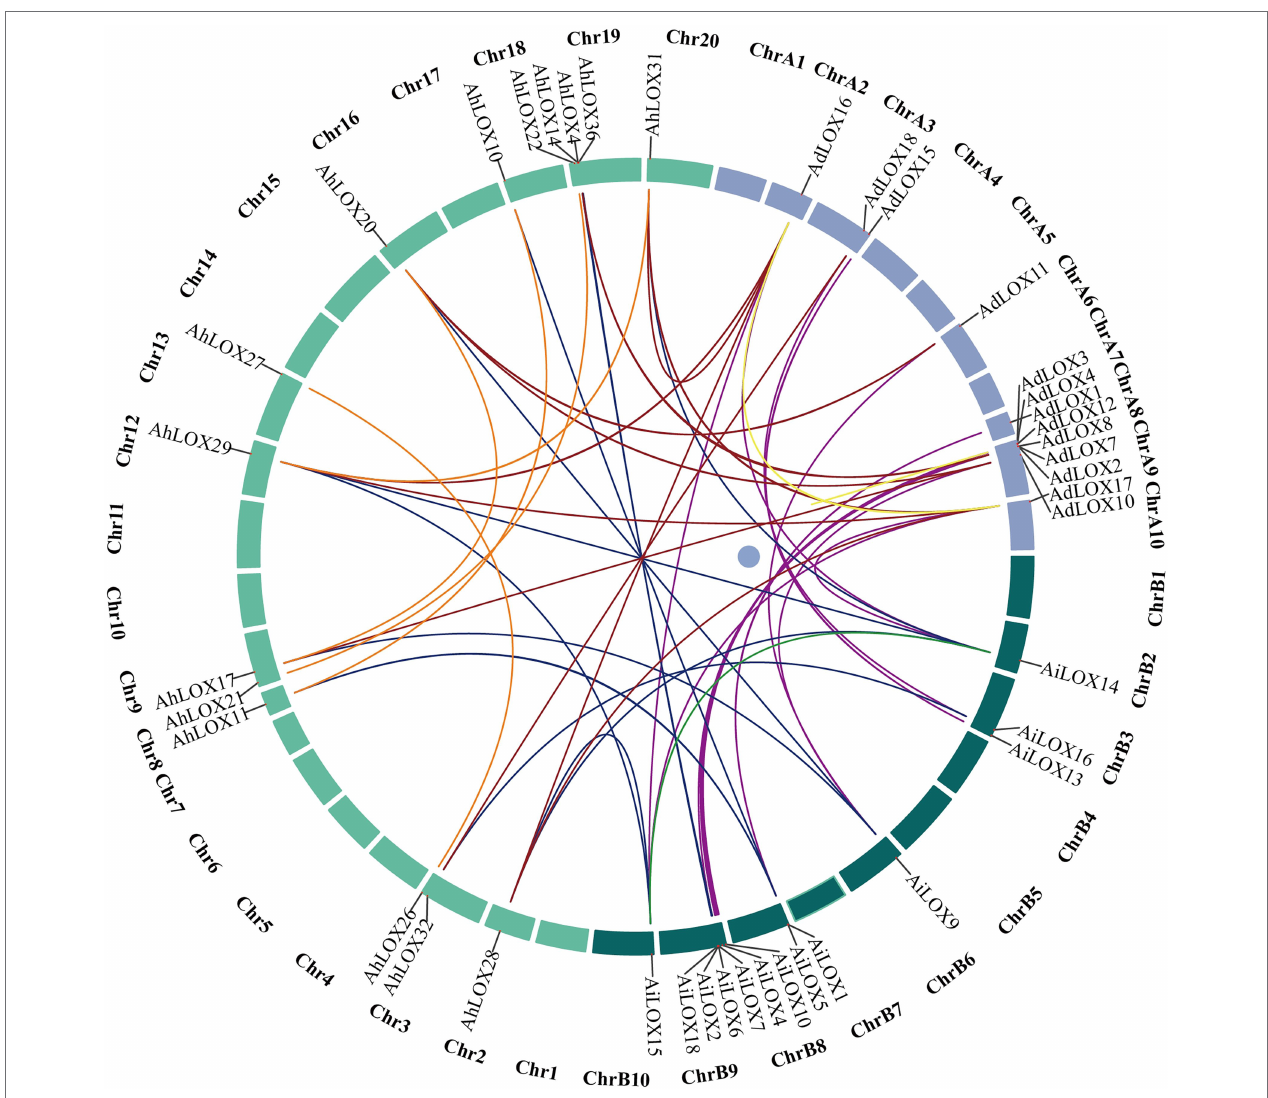
FIGURE 6 | Segmentally duplicated gene pairs of LOXs in peanut. The lines highlighted in different colors indicate duplicated LOX gene